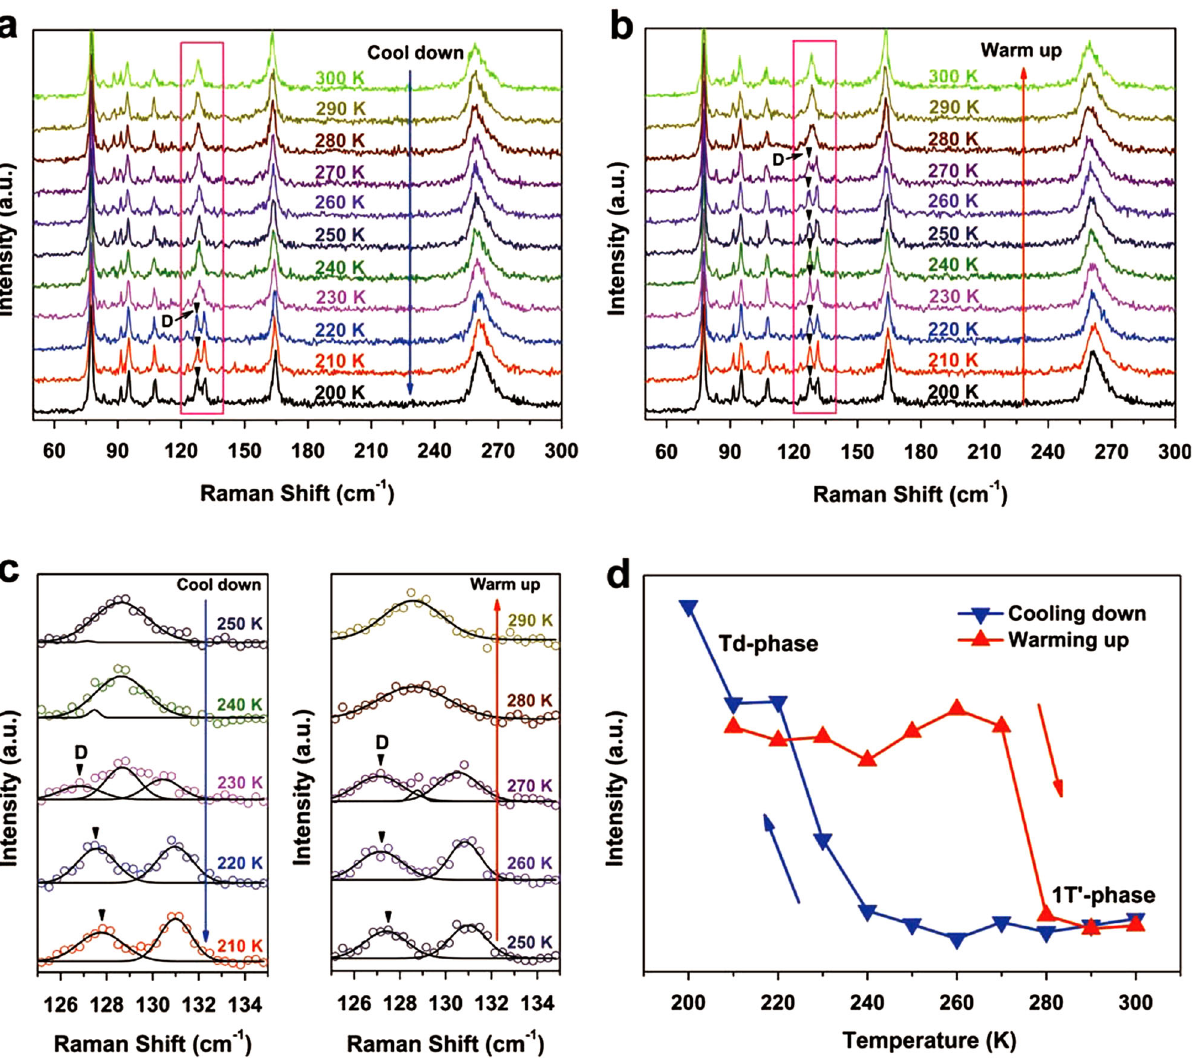
Fig. 4 a and b Raman spectra of metastable phase MoTe 2 at various temperatures in the cooling down a and warming up b routes. The D mode noted by balck arrows at ~127.8 cm − 1 indicate the existence of Td-phase with a broken inversion symmetry. c Extended Raman spectra ( circular holes ) around 130 cm − 1 fi tted by the Gaussian function ( black solid lines ) near the temperature of phase transitions in the opposite routes. d Temperature dependence of the fi tted intensities of Raman mode D in two opposite temperature routes which are indicated by